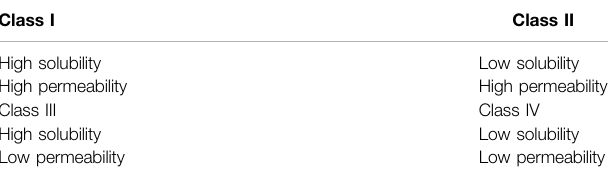
TABLE 2 | The biopharmaceutics classi fi cation